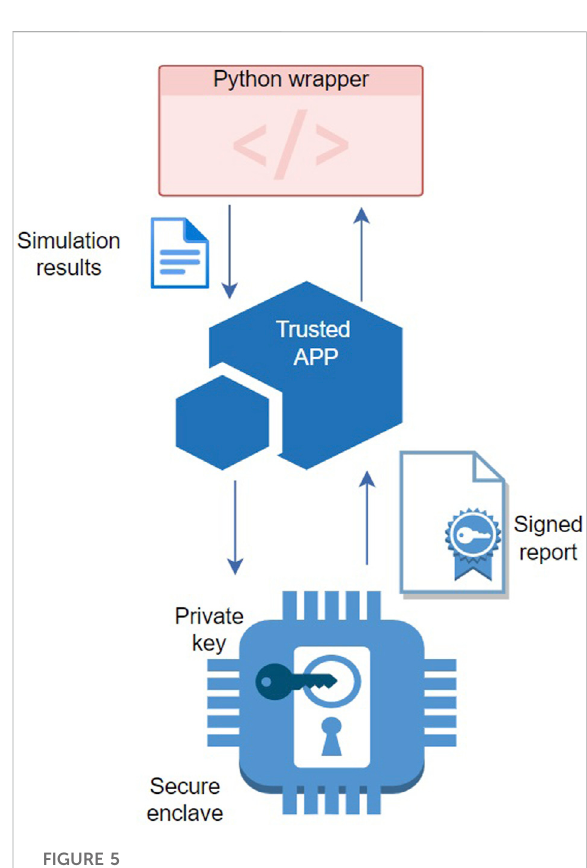
FIGURE 5 Communication between the Python wrapper, the trusted app, and the secure enclave which stores the private signing